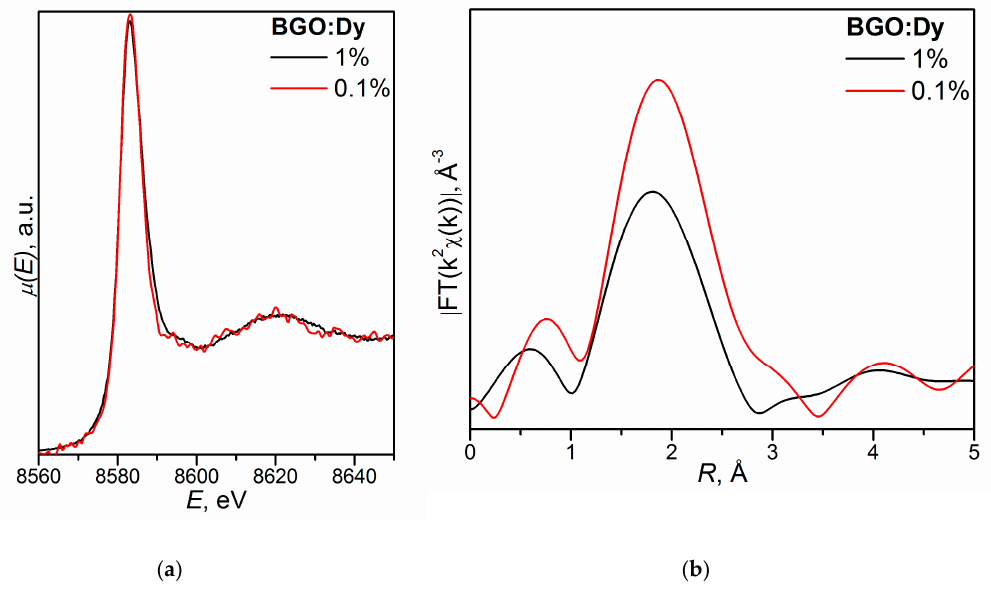
Figure 8. Dy L 2 -edge ( a ) XANES spectra and ( b ) EXAFS Fourier transforms ( k -range, 2–6 Å − 1 ) for the BGO:1.0Dy and BGO:0.1Dy samples.